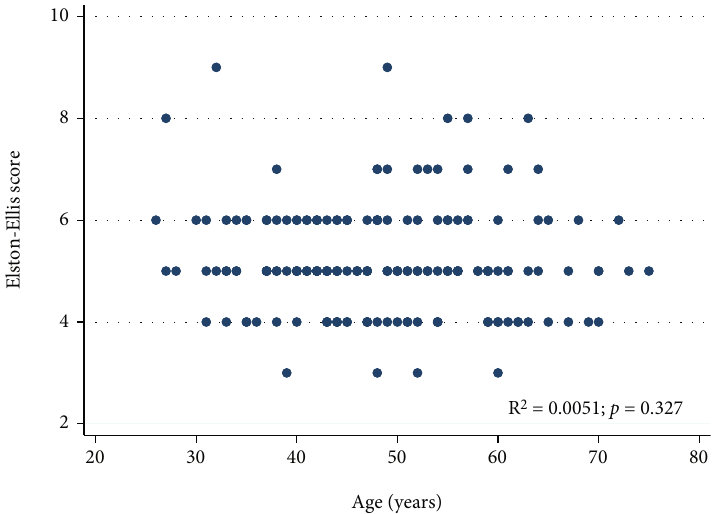
R 2 = 0.0051; p = 0.327